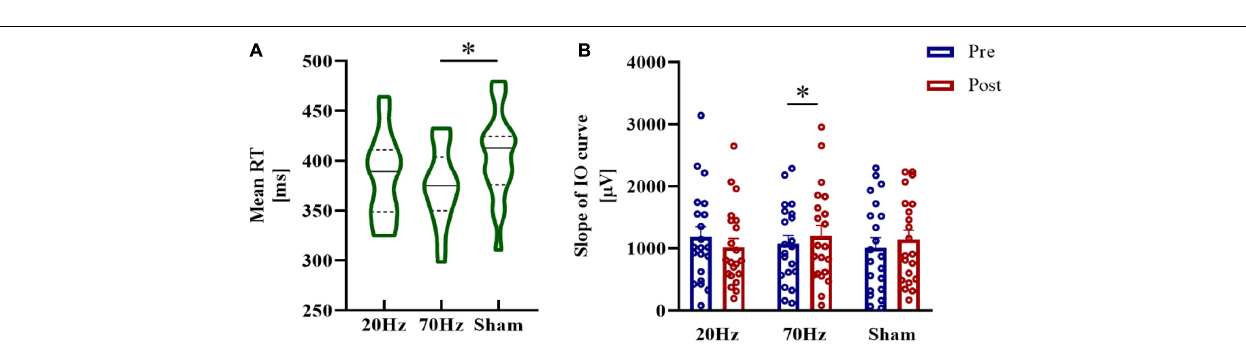
FIGURE 3 | Results of the RRTT experiment. (A) The mean RT of the 70 Hz condition was significantly smaller than that of the sham condition. (B) Significant increases in the IO slope after TI stimulation were found only in the 70 Hz condition. Error bars represent SEM; ∗ significant at p corrected <